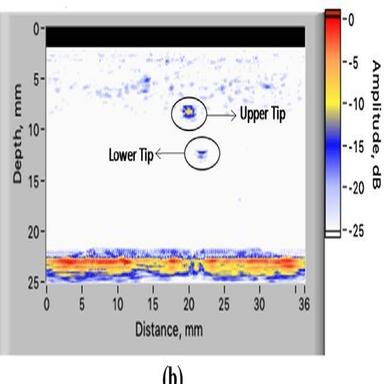
(a) Weld sample with lack of sidewall fusion and (b) Processed B-scan image by PA-SAFT.